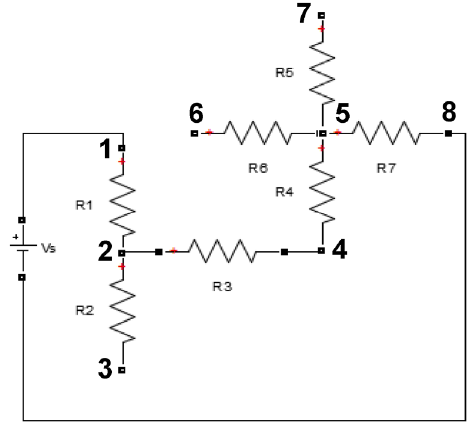
Figure 13. Example case of a resistor network.